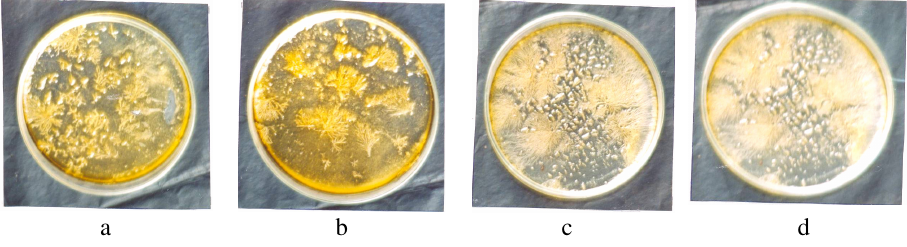
Figure 5 . Photographs of trees / bushes patterns.